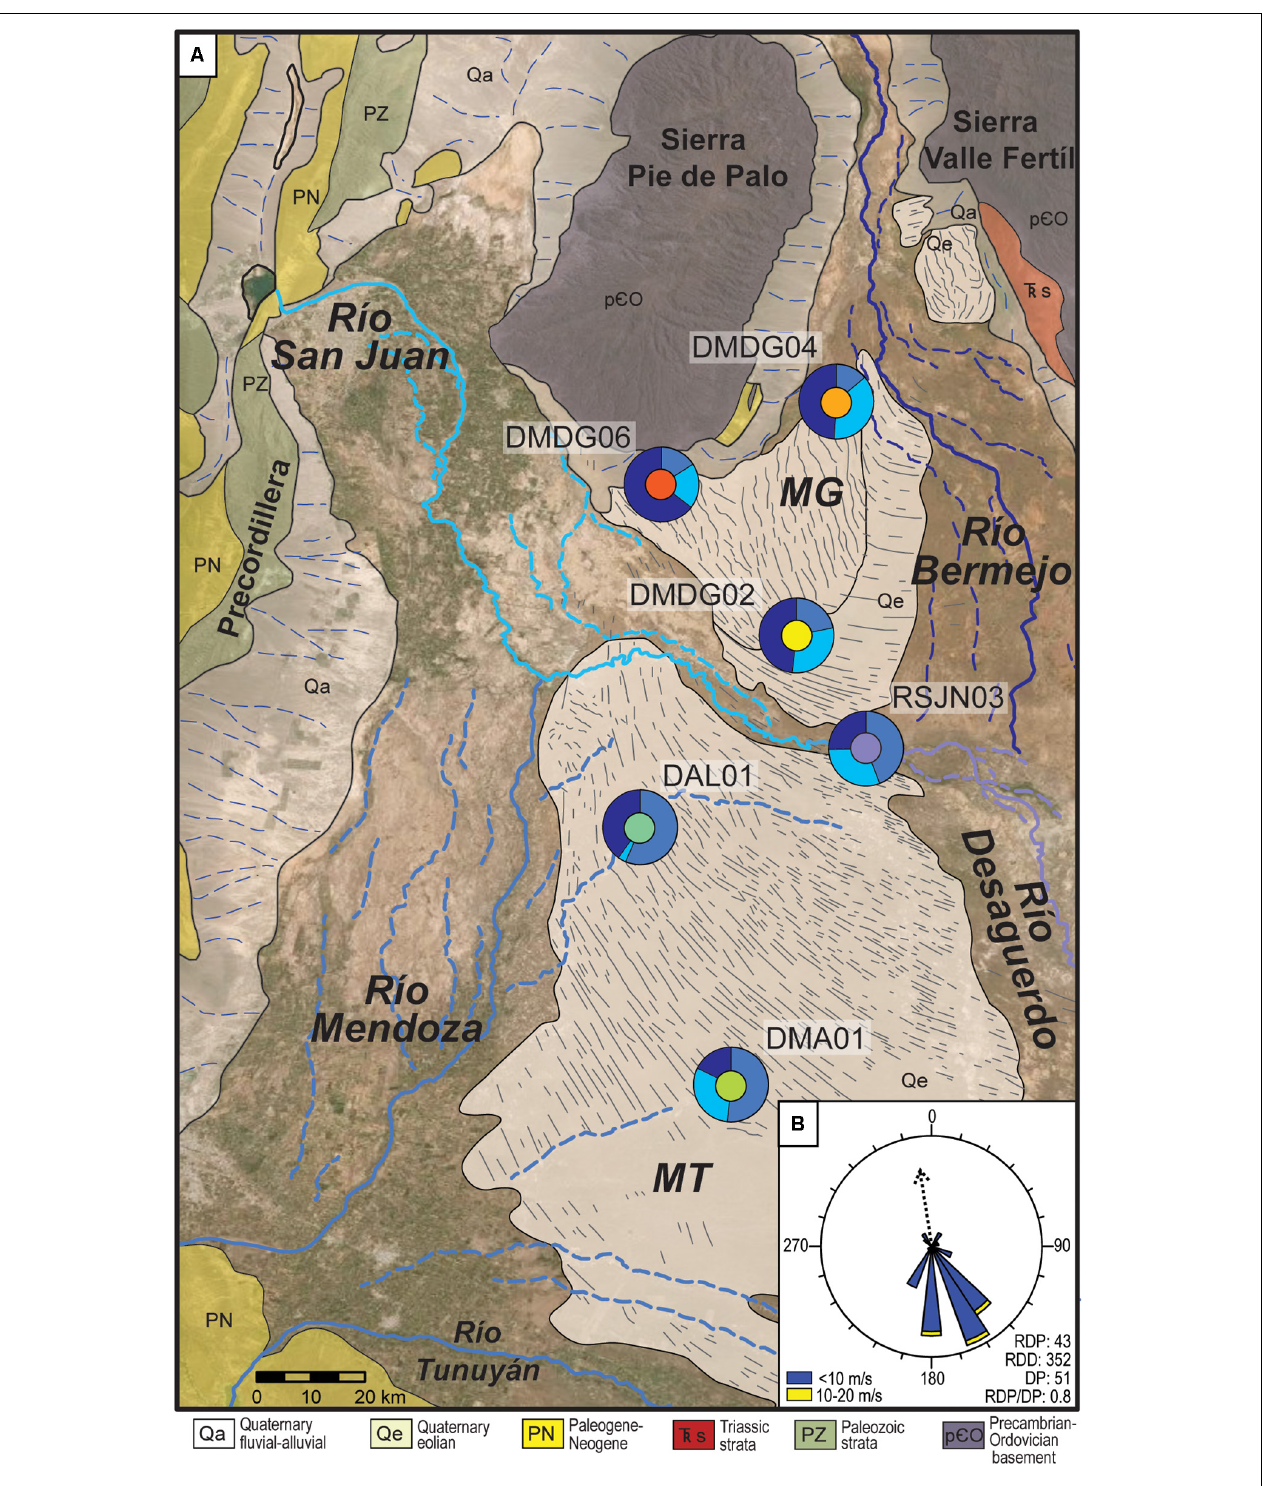
FIGURE 7 | Geomorphic map of eolian and fluvial megafan systems in Andean foreland sediment transfer zone. (A) Holocene eolian and modern distal fluvial samples detrital zircon mixing model results are plotted as donut diagrams (see Figure 6 ), where Medanos Telteca (MT) and Medanos Grande (MG) sands have distinct mixed proportions of fluvial megafan sediment inputs. (B) Rose diagram of modern wind vectors collected from San Juan that are capable of transporting sand-sized sediments ( < 10 and 10–20 m/s) (modified from Tripaldi and Forman, 2007).